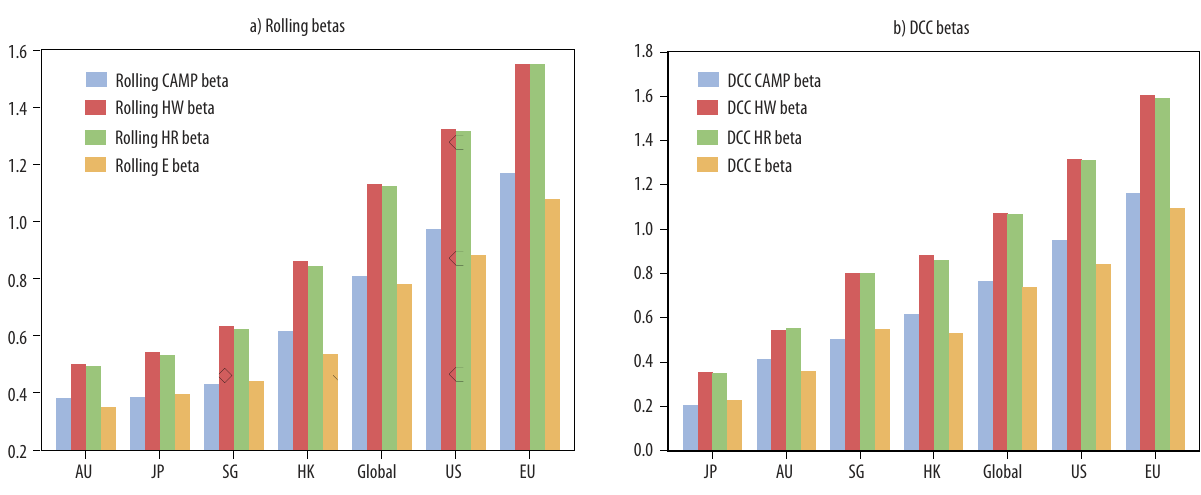
Fig. 5. The mean betas of seven REIT markets